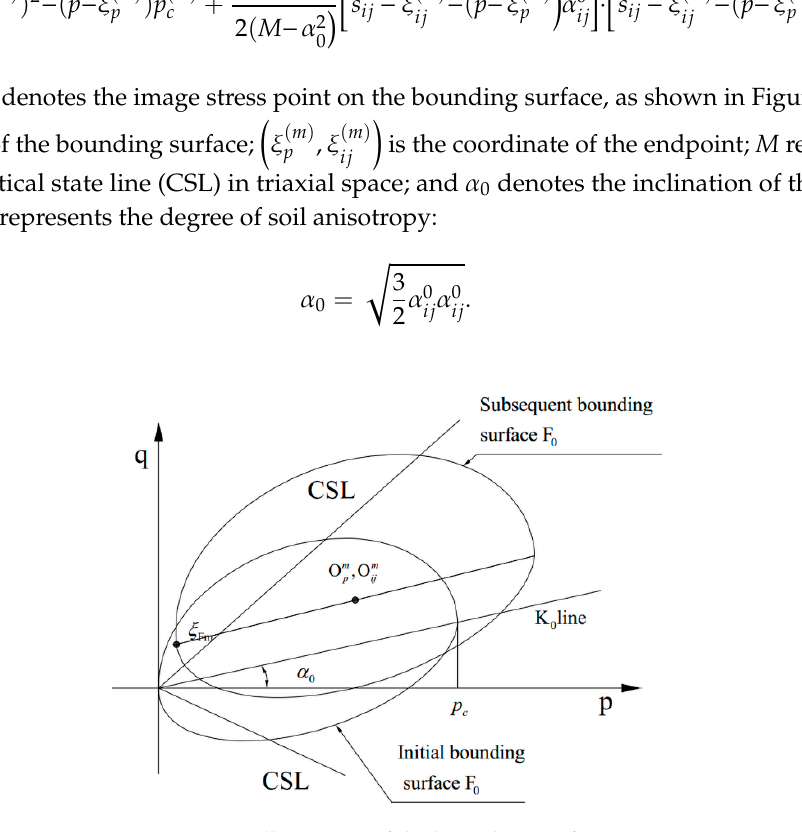
Figure 2. Illustration of the bounding surface.